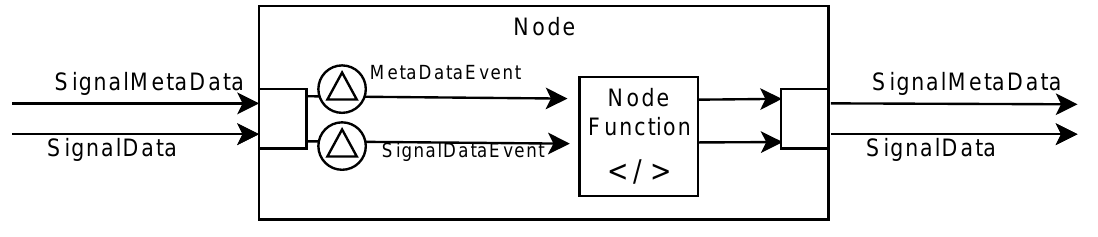
Figure 13. Schema of a SPP node.